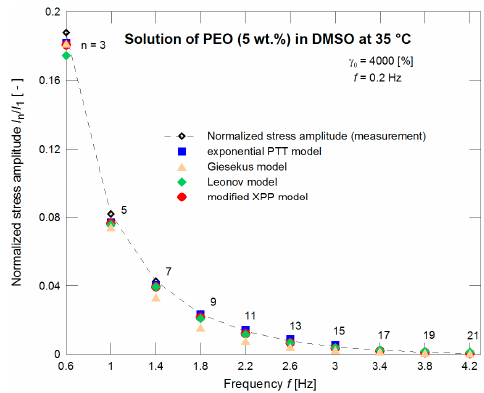
Figure 6. A description of the normalized stress amplitudes by the exponential PTT, Giesekus, Leonov, and modified XPP models using the nonlinear parameters optimized with respect to the steady shear viscosity measurements (Figure 4) for strain of 4000%.